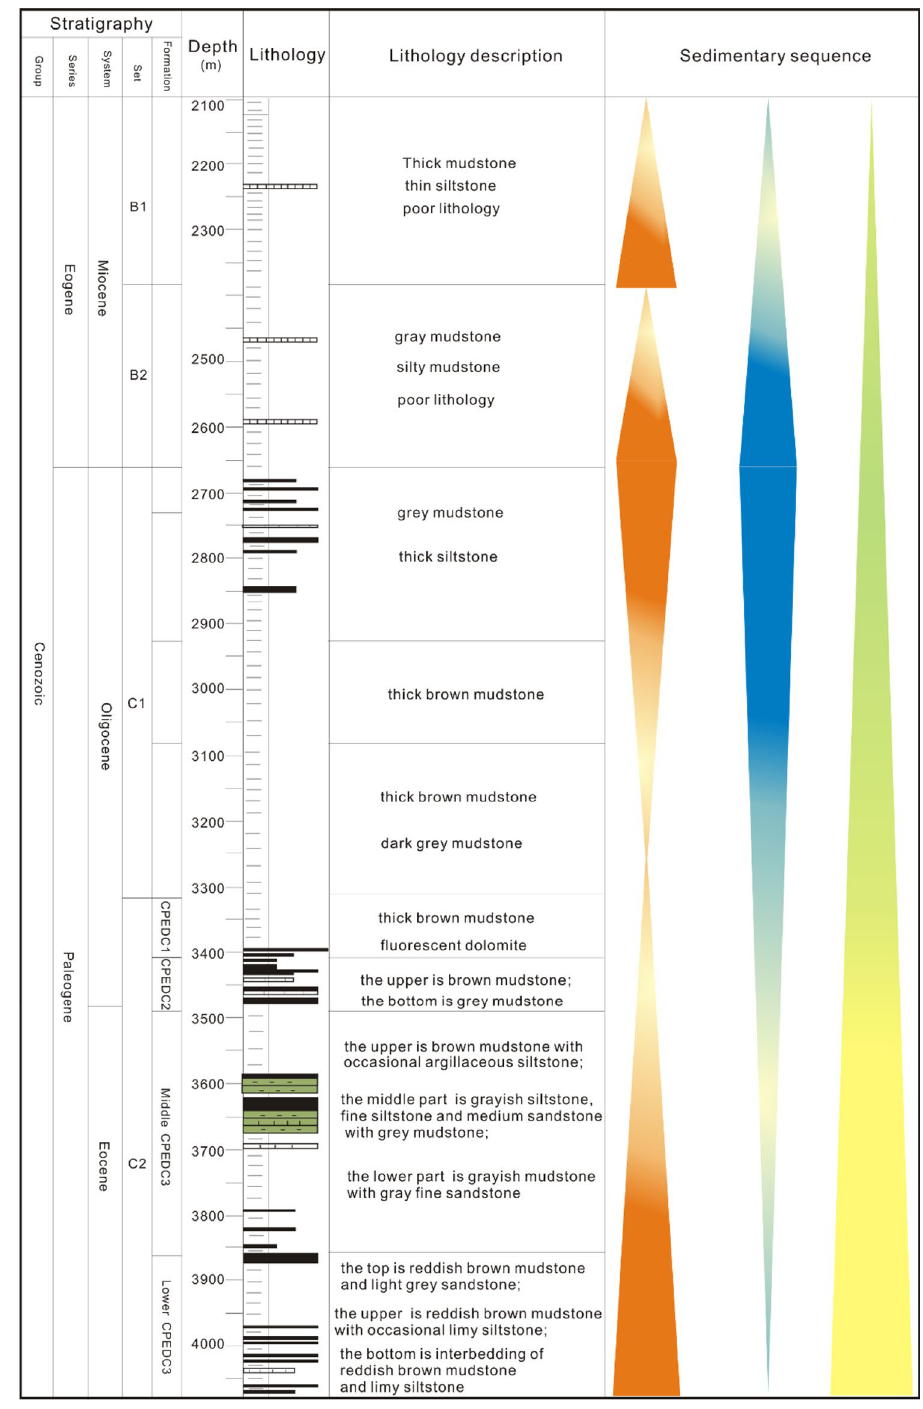
Fig. 2 Synthetical